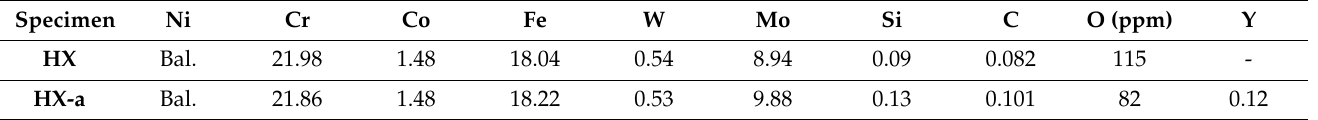
Table 1. Chemical composition